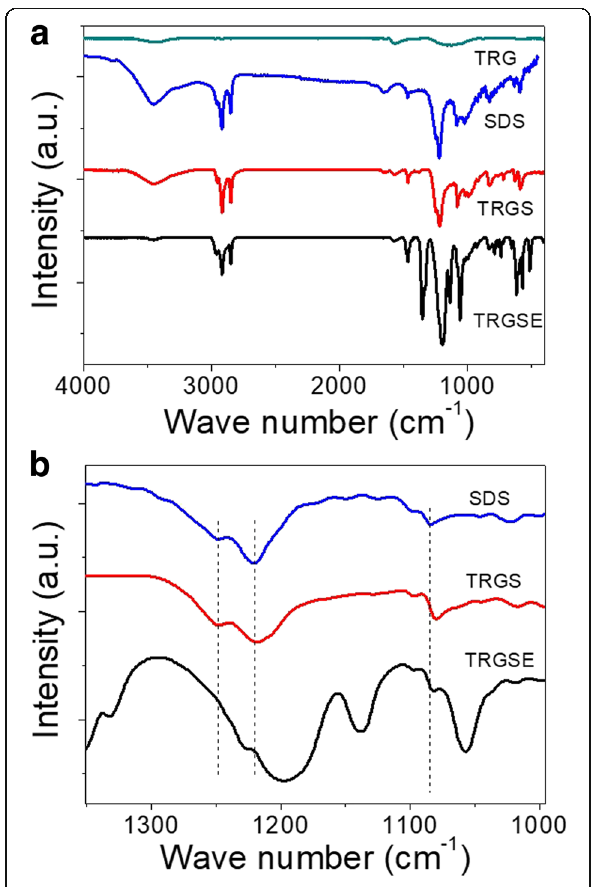
Fig. 4 a FTIR spectra of the TRG, SDS, TRGS, and TRGSE. ( b ) Zoom in of a for a specific wavenumber